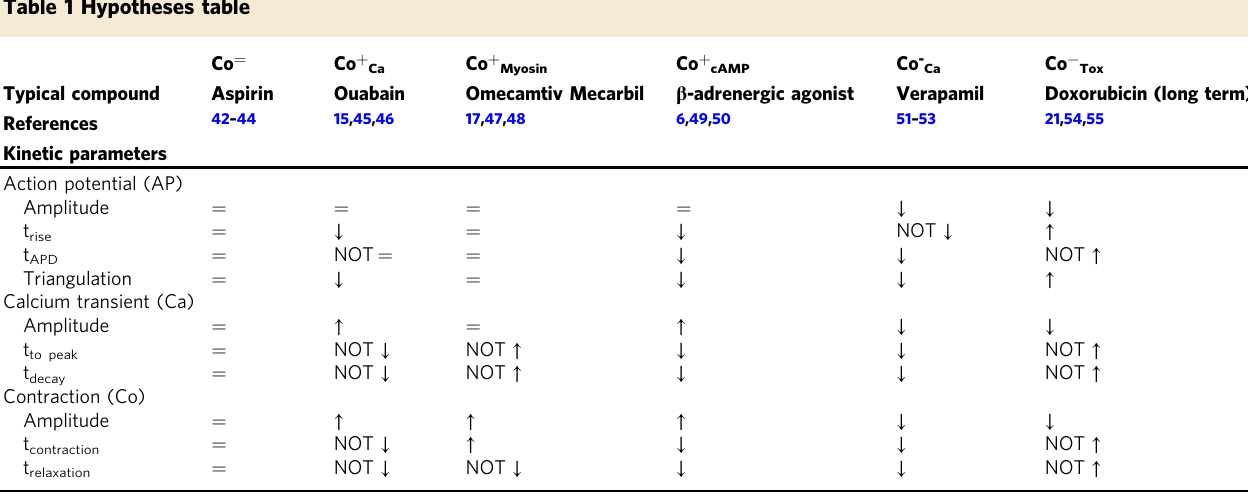
Table 1 Hypotheses table